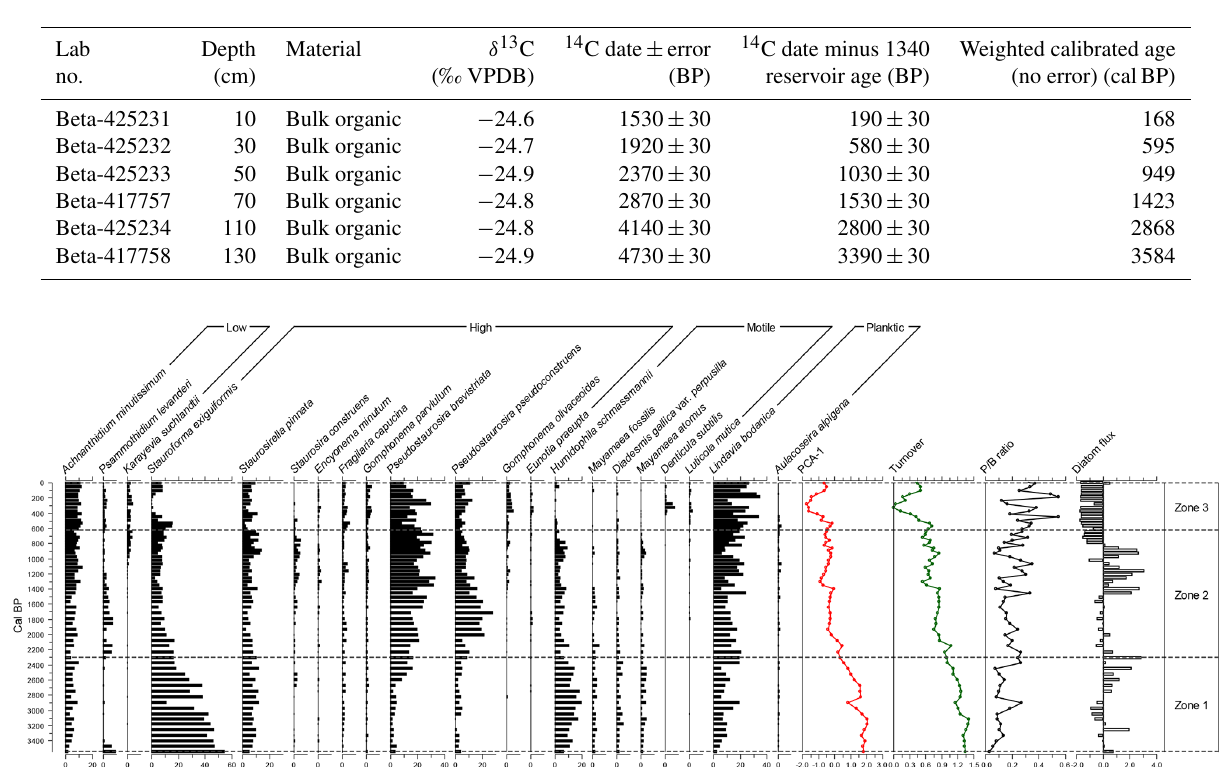
Table 1. AMS- 14 C radiocarbon dates from Yuhuang Chi lake (core YHC15A).